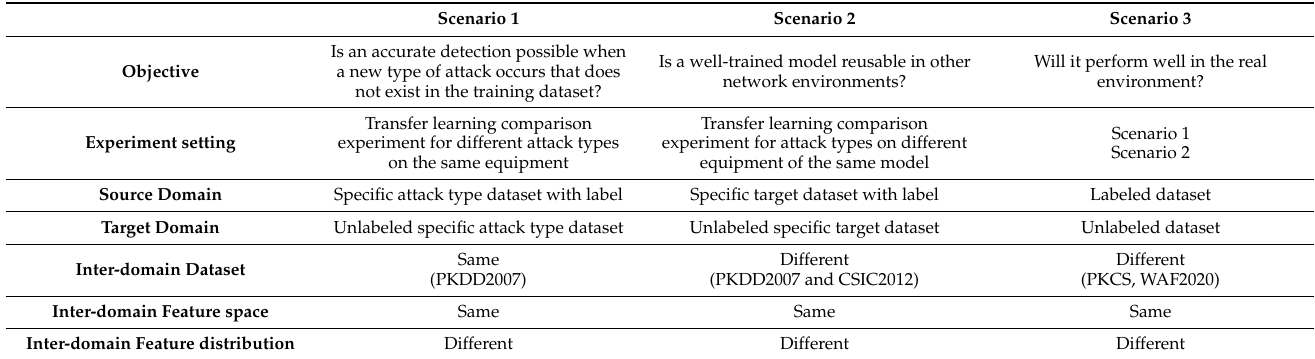
Table 3. Description and configuration by